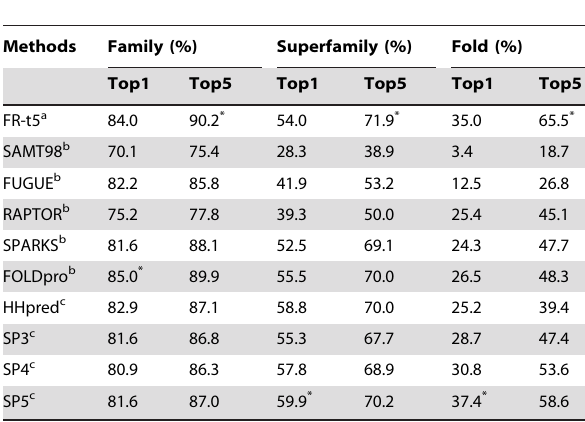
Table 5. The comparison of FR-t5 with other methods for fold recognition on the Lindahl